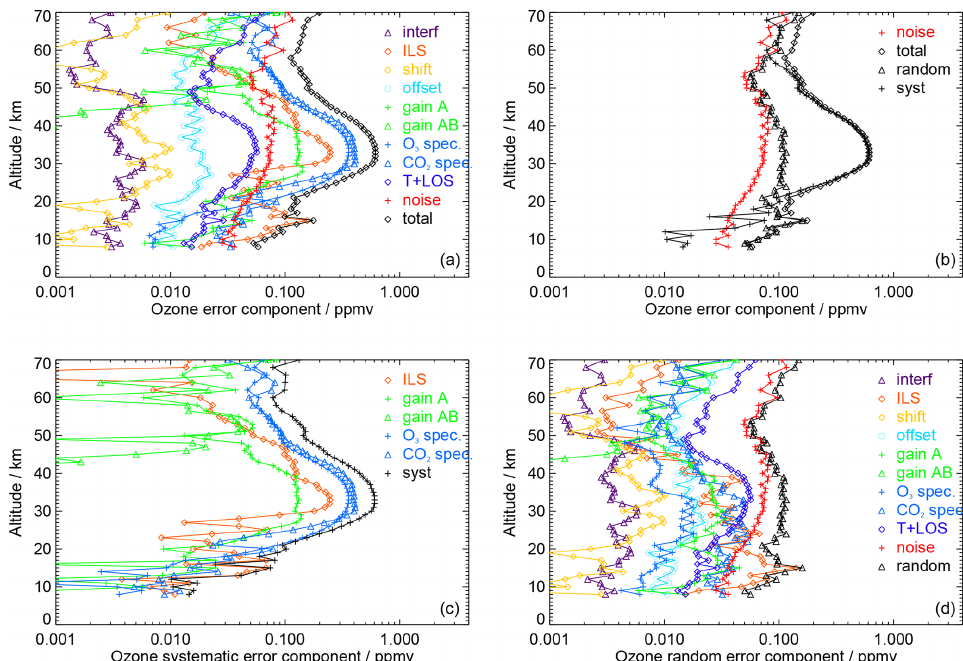
Figure 3. Aggregated estimated ozone errors for the northern midlatitude summer night reference scenario. (a) The total error budget and its components (interf is the interfering species, and ILS is the instrument line shape). (b) The decomposition into random and systematic components. The contributions to the systematic (c) and random (d error budgets. This example was taken from Kiefer et al.